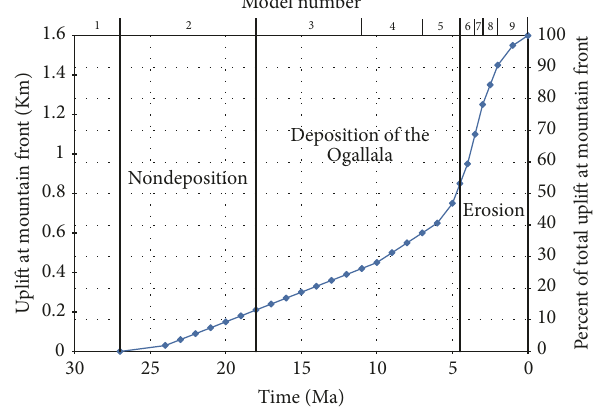
Figure 8: Estimated cumulative uplift and percent of total uplift as a function of time since 27Ma, with model numbers and superimposed periods of deposition and